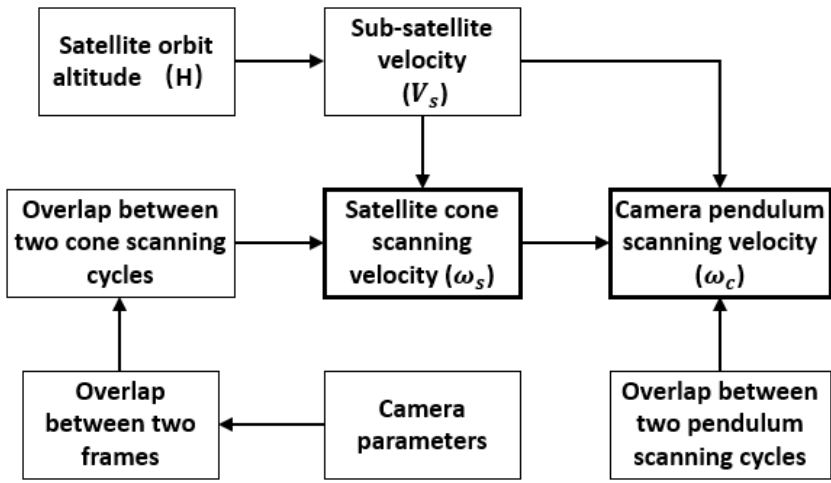
Figure 8. The design flow chart of these three motion parameters.